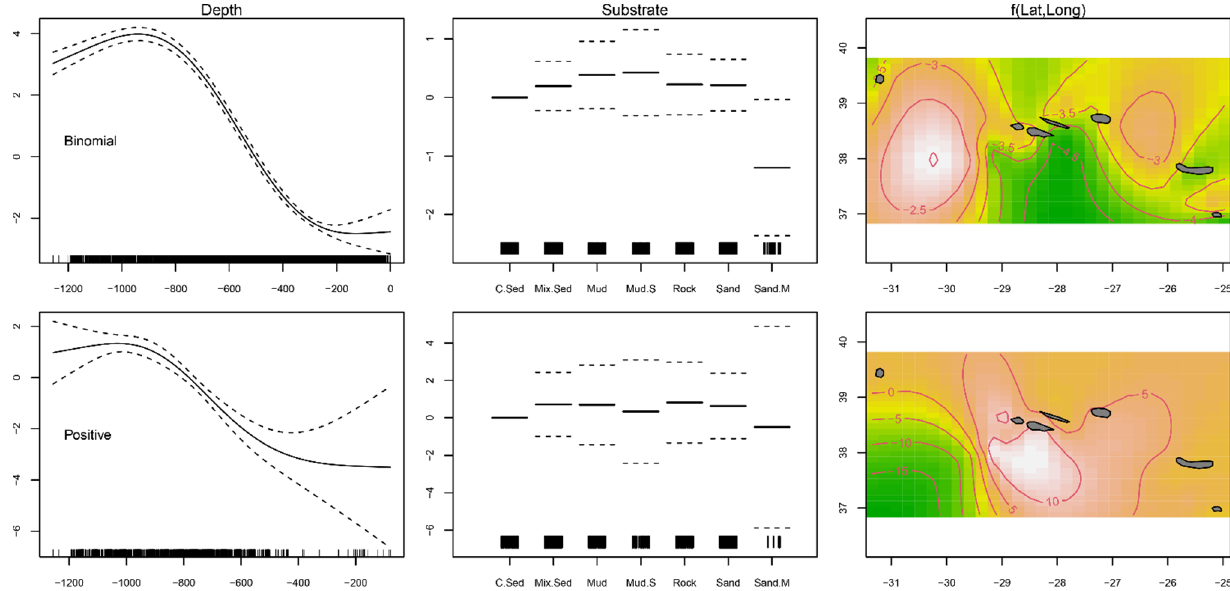
Figure 2. Residual plots for predictors obtained by the presence–absence binomial and abundance Gaussian generalized additive models (GAMs) for Mora moro caught during the surveys (1996–2019) in the Azores. Each column shows a predictor (depth, substrate and latitude and longitude) in the context of the model. Solid and dashed lines represent the smoother fit and the approximate ± 0.95 confidence interval, respectively. Observed data points are indicated as tick marks on the x -axis. In the 2D smoother colored plot, white color indicates more individuals and green color fewer. Table 1. Detailed summary table of generalized additive model (GAM) results for the Mora moro abundances derived from the surveys (1996–2019) in the Azores. Substrate type: coarse sediment (C. Sed), mixed sediment (Mix.Sed), mud (Mud),